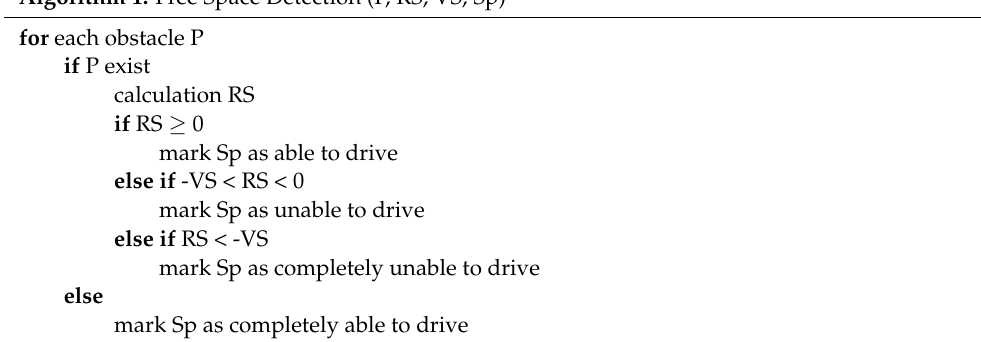
Algorithm 1. Free Space Detection (P, RS, VS,